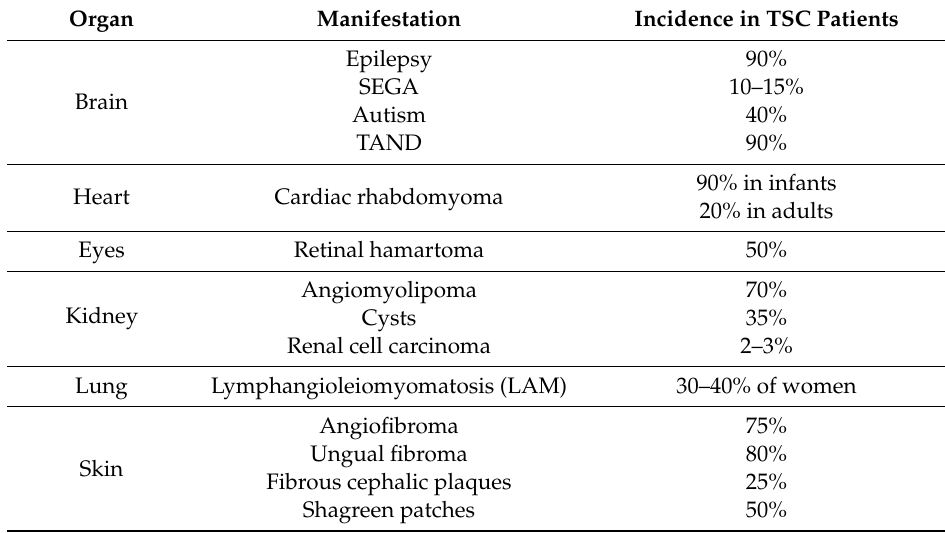
Table 2. Manifestations of TSC. TSC is a spectrum disorder that presents with various symptoms in each single patient [92,93]. The table lists the incidence of each